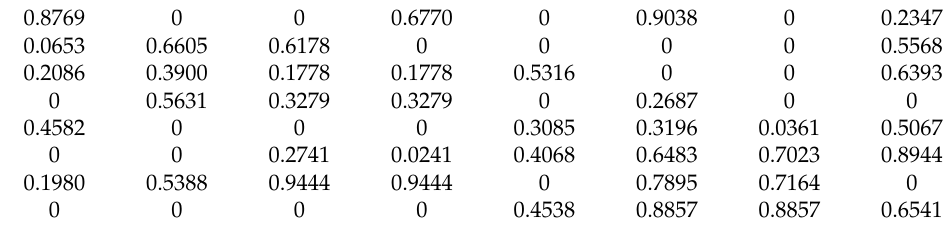
Figure 6. Optimized radiation pattern with the PS method. Table 1. Optimized weights for random 25 element failure with the PS method.